Question: Provide a one-line summary of what is displayed.
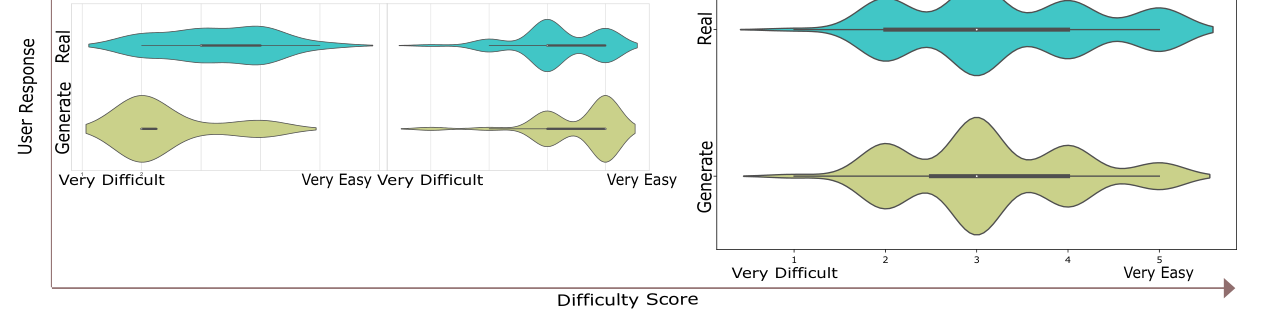
Answer: Figure shows the distribution of difﬁculty/easiness of the Turing test as rated by users. Although individual opinions on the difﬁculty level of images vary between users (example UserID 2 and 6), the overall distribution of the score averages out with a slightly longer tail towards easy than difﬁcult.